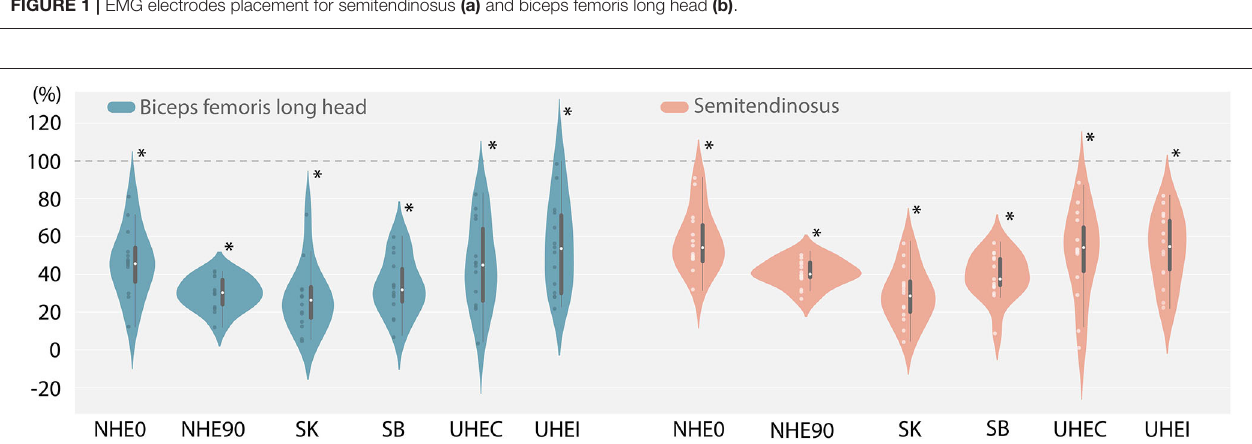
FIGURE 1 | EMG electrodes placement for semitendinosus (a) and biceps femoris long head (b) .